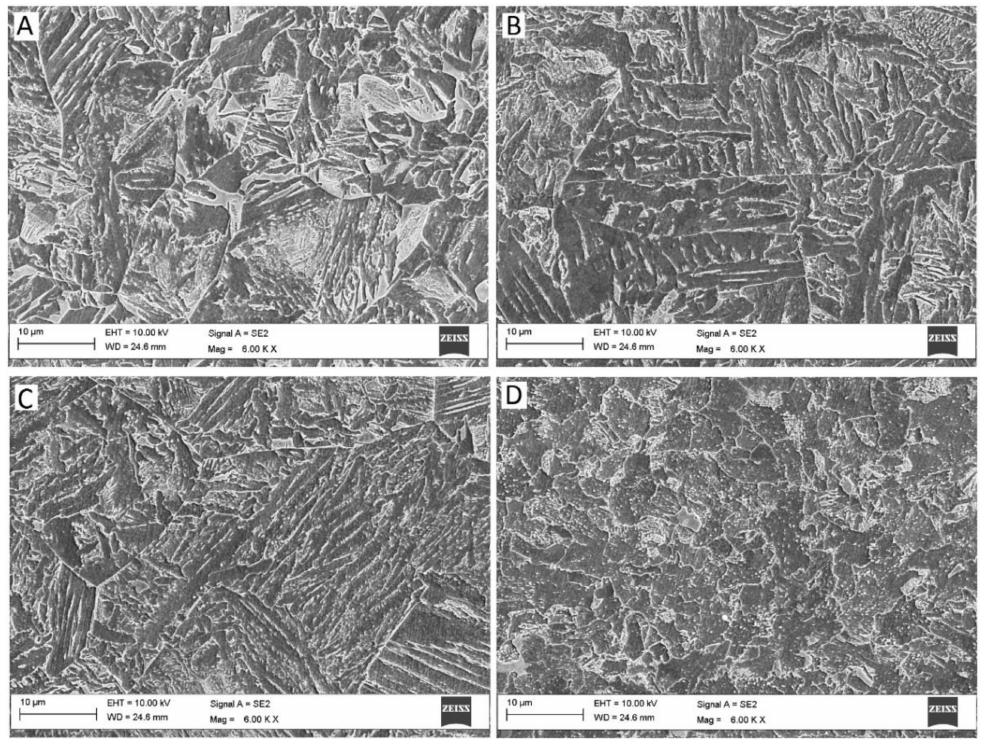
Figure 19. SEM images from high heat input weld (t 8/5 = 20 s) HAZ for steel S690QL. ( A – D ) are locations established in Figure